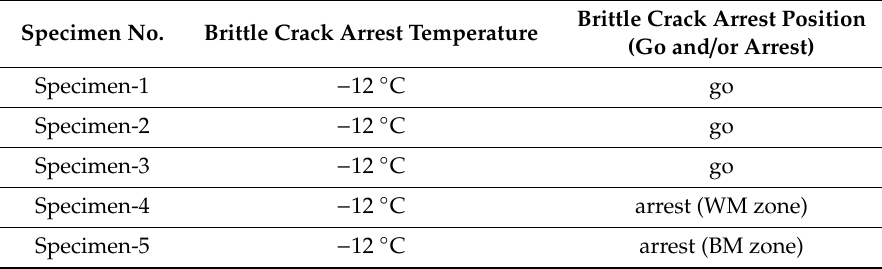
Table 7. Summary of the brittle crack arrest experimental